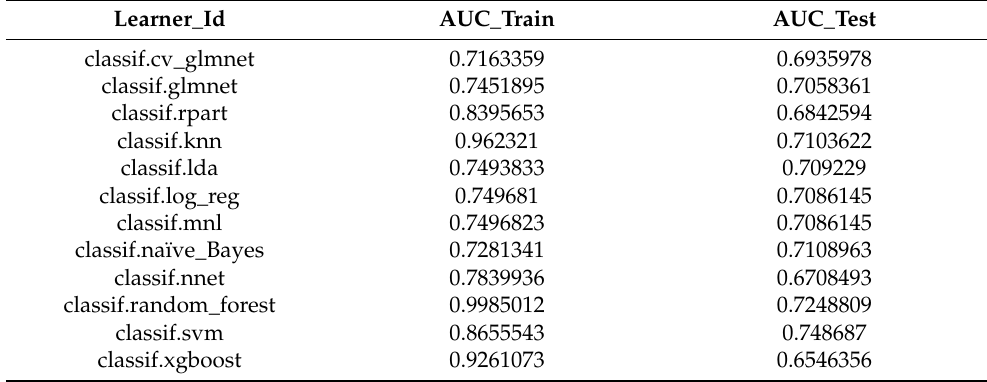
Table 1. The efficiency of twelve models based on multiple machine learning